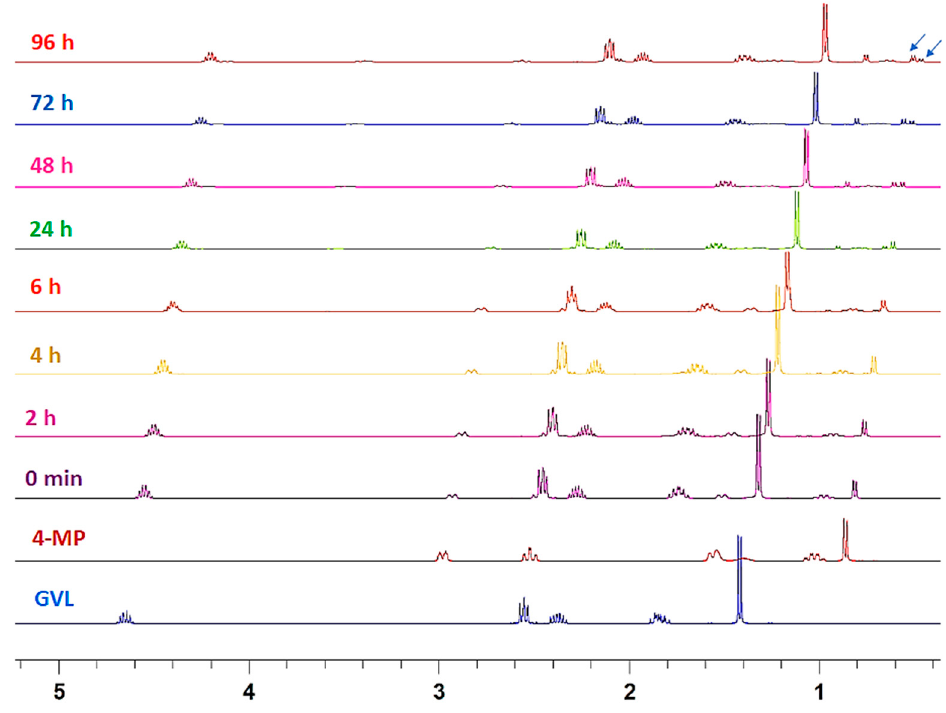
Figure 3. Time-dependent 1 H-NMR study of the formation of piperidide 3b by ring opening of GVL with 20% 4-MP. Arrows indicate the signals selected for calculation of the percentage of ring opening.